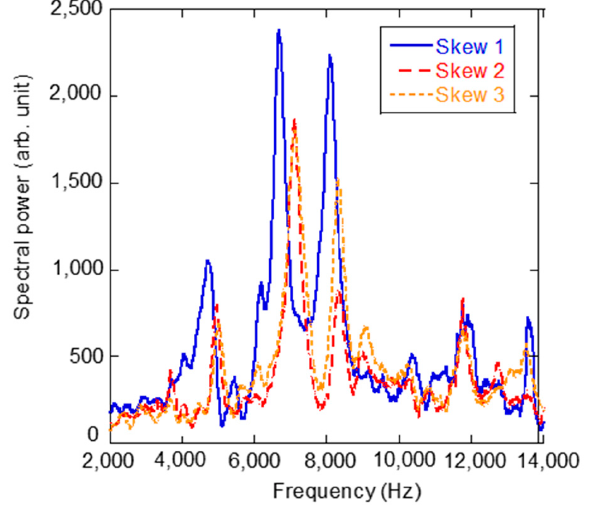
Figure 5. Variation in laser-induced vibration at the same tilt direction when tilted repeatedly.